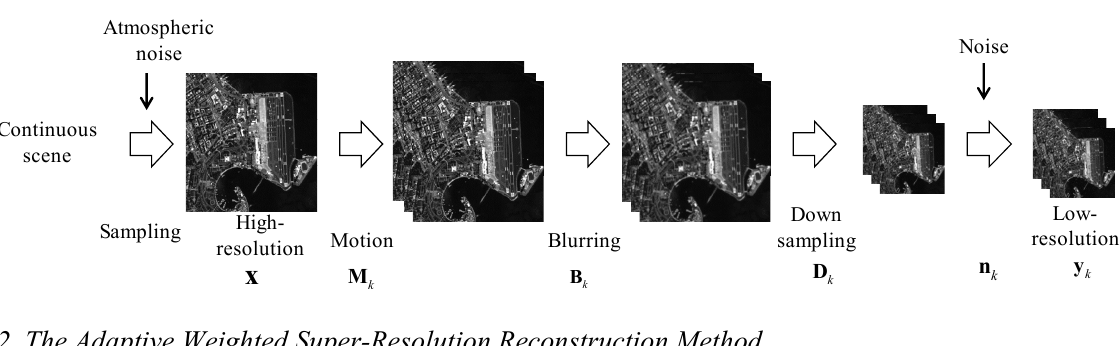
Figure 1. Simulation imaging process for acquiring the digital images, where the desired HR image is at the left side with the observed image at the extreme